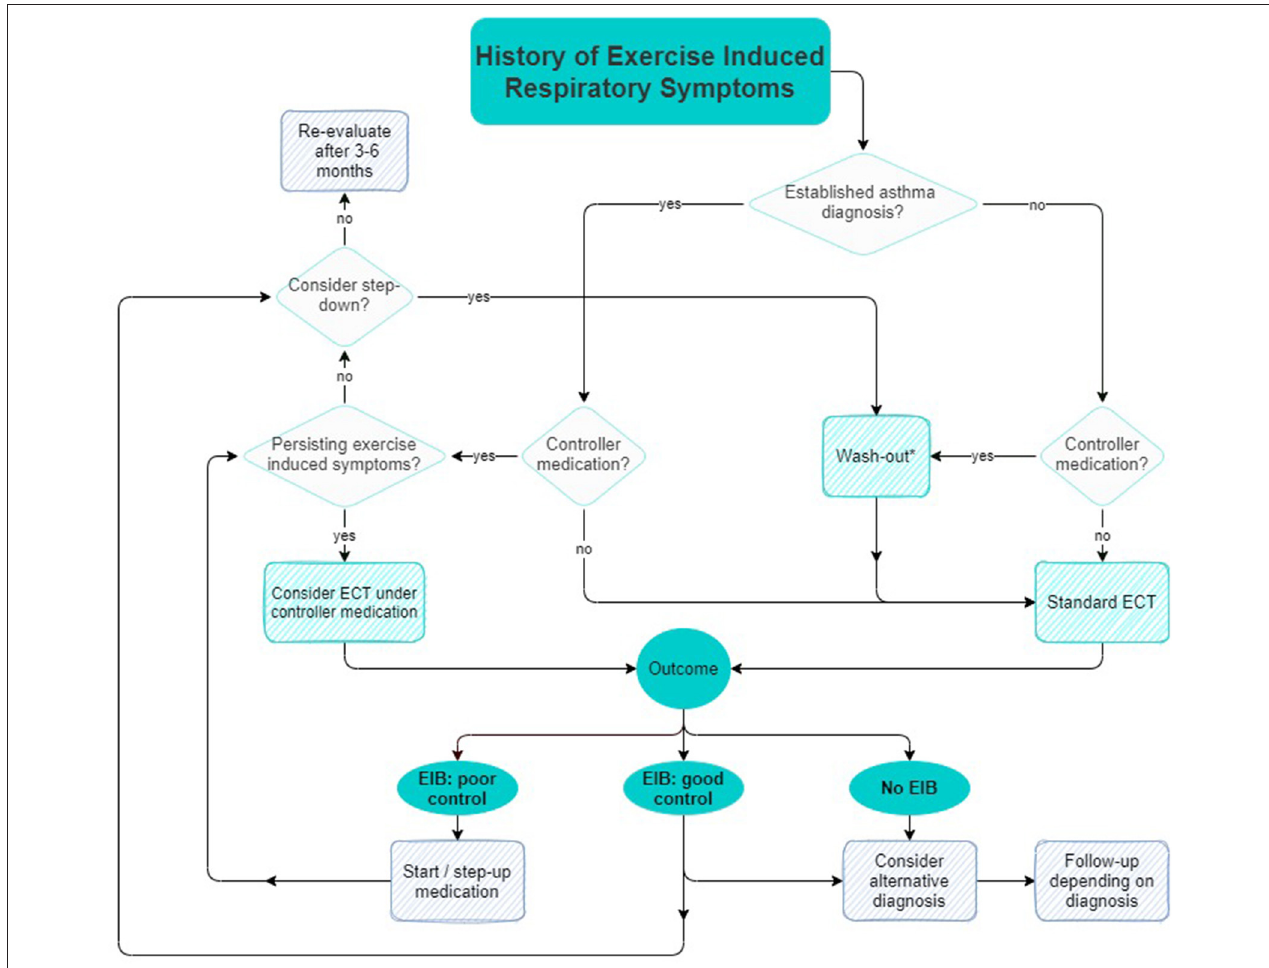
FIGURE 1 | Suggested algorithm for strategic continuation or restriction of asthma medication prior to an